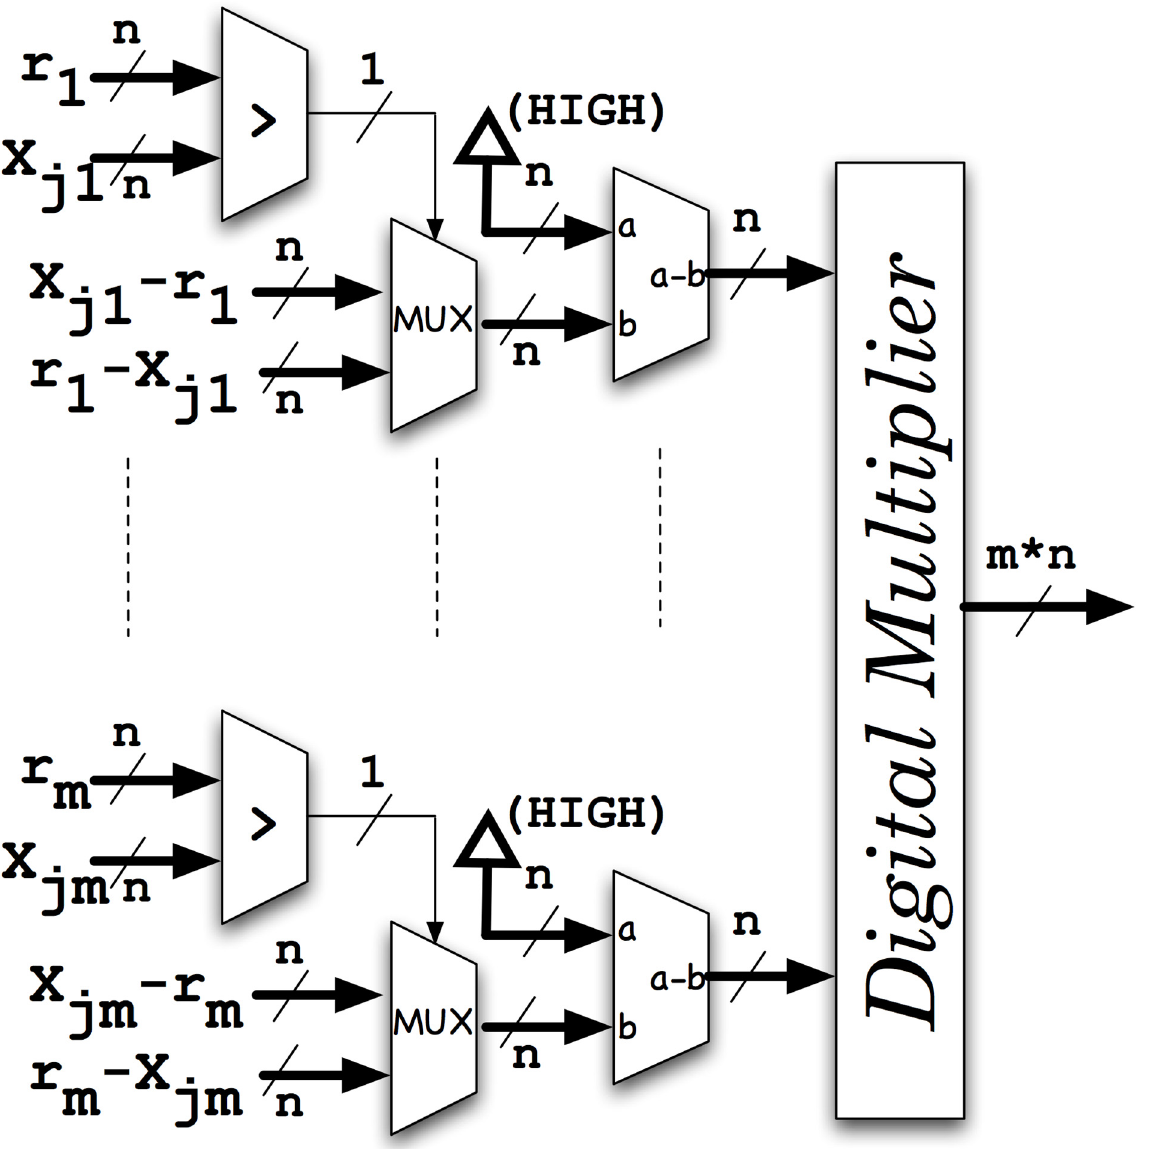
Fig 16. Conventional implementation of a m-dimensional digital comparator where expression (1) is implemented. The first comparator and the multiplexer implement the absolute value function while the multiplier provide the product for all the